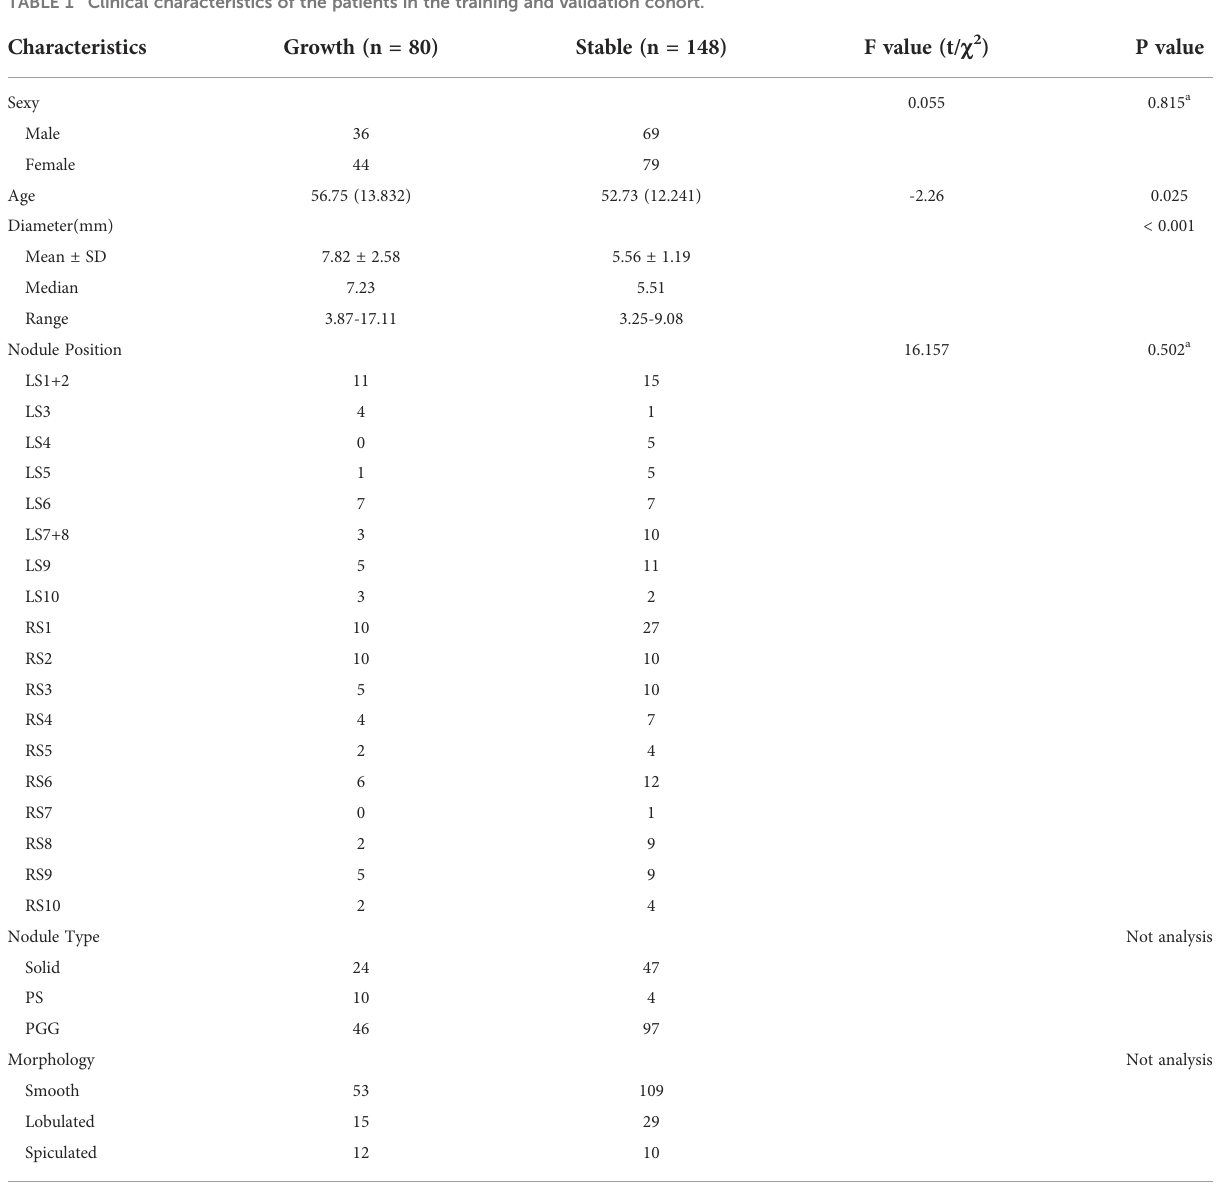
TABLE 1 Clinical characteristics of the patients in the training and validation